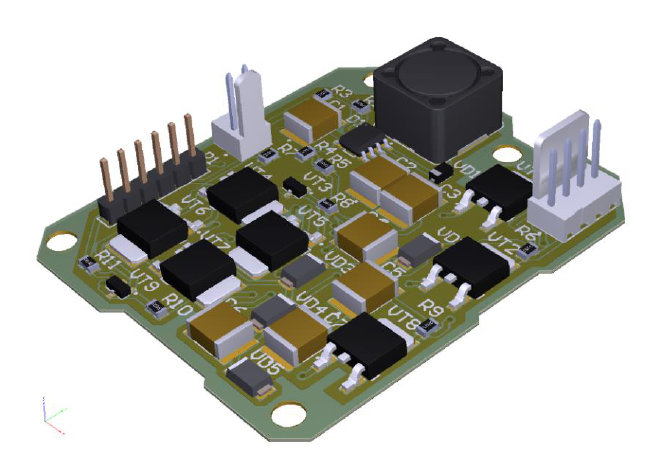
Figure 5. 3D model of the developed driver’ PCB design